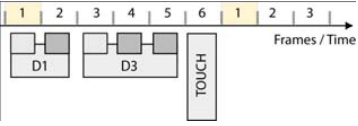
Figure 8. Modified sequential protocol